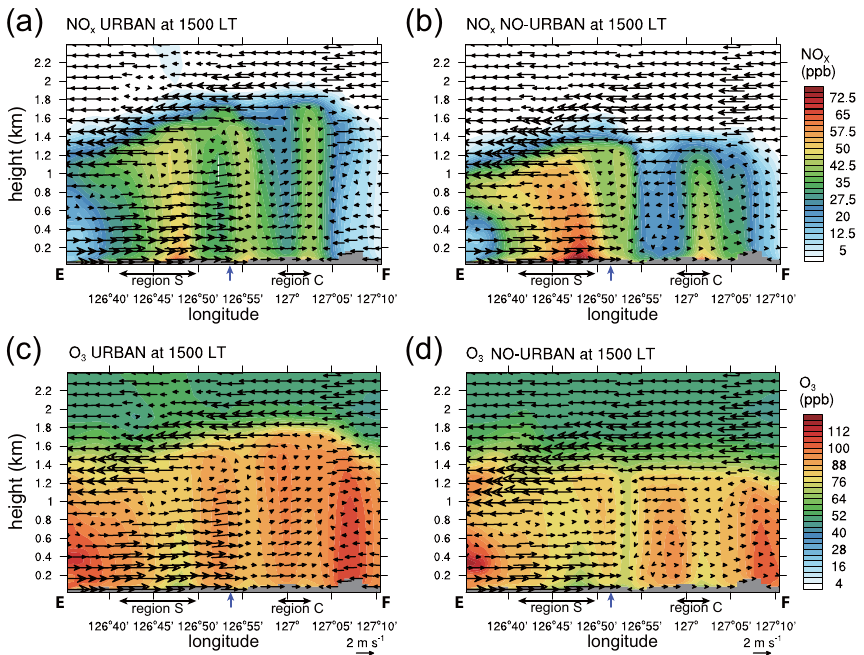
Fig. 14. Vertical cross sections of (a) NO x and (c) O 3 concentrations and wind along the line E–F in Fig. 1c at 15:00 LT in the URBAN simulation. (b) and (d) are the same as (a) and (c) , respectively, but for the NO-URBAN simulation. The blue arrow indicates the location of the sea-breeze